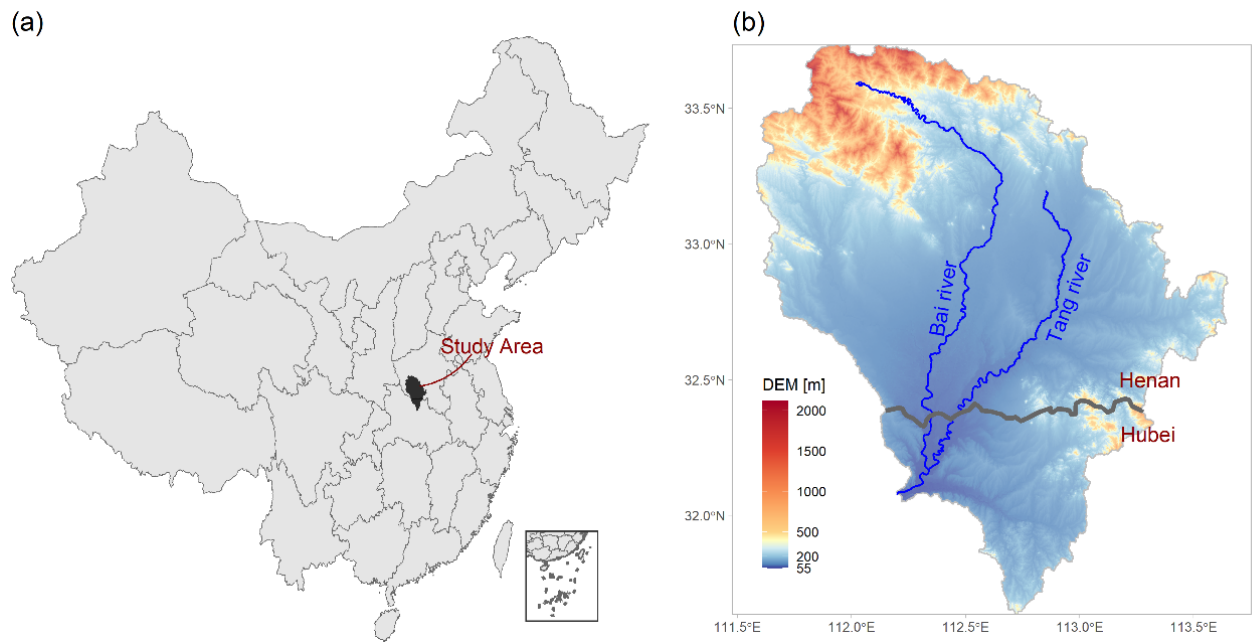
Figure 1. Geographic location ( a ) and 90 m digital elevation map (DEM, b ) of the Tangbai River Basin, a shared river basin of Henan province and Hubei province. The curved path in ( b ) is the provincial boundary, and the blue lines are the two major tributaries constituting the Tangbai River.